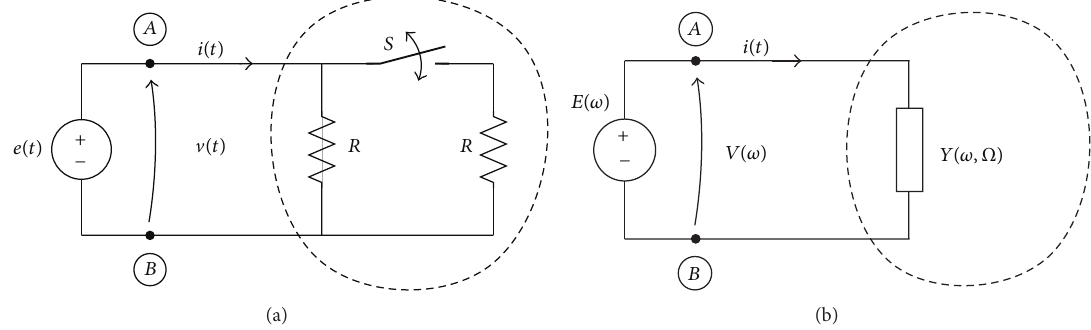
Figure 2: (a) Example circuit consisting of the interconnection of an ideal voltage source and of a switching resistive PSL block. (b) Circuit with the PSL block described by means of its generalized bifrequency admittance 𝑌(𝜔,Ω)